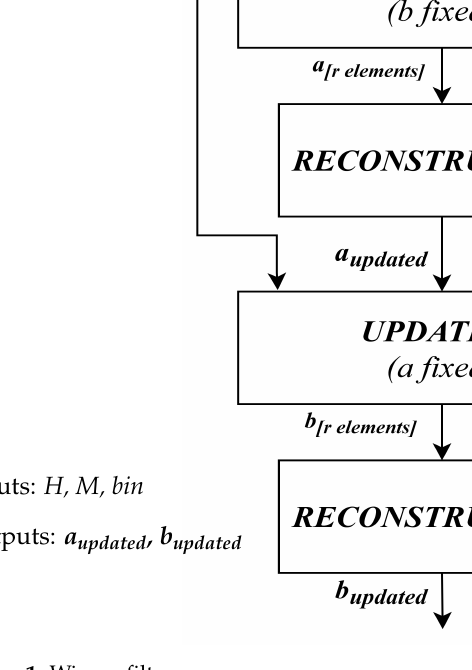
Figure 1. Wiener filter